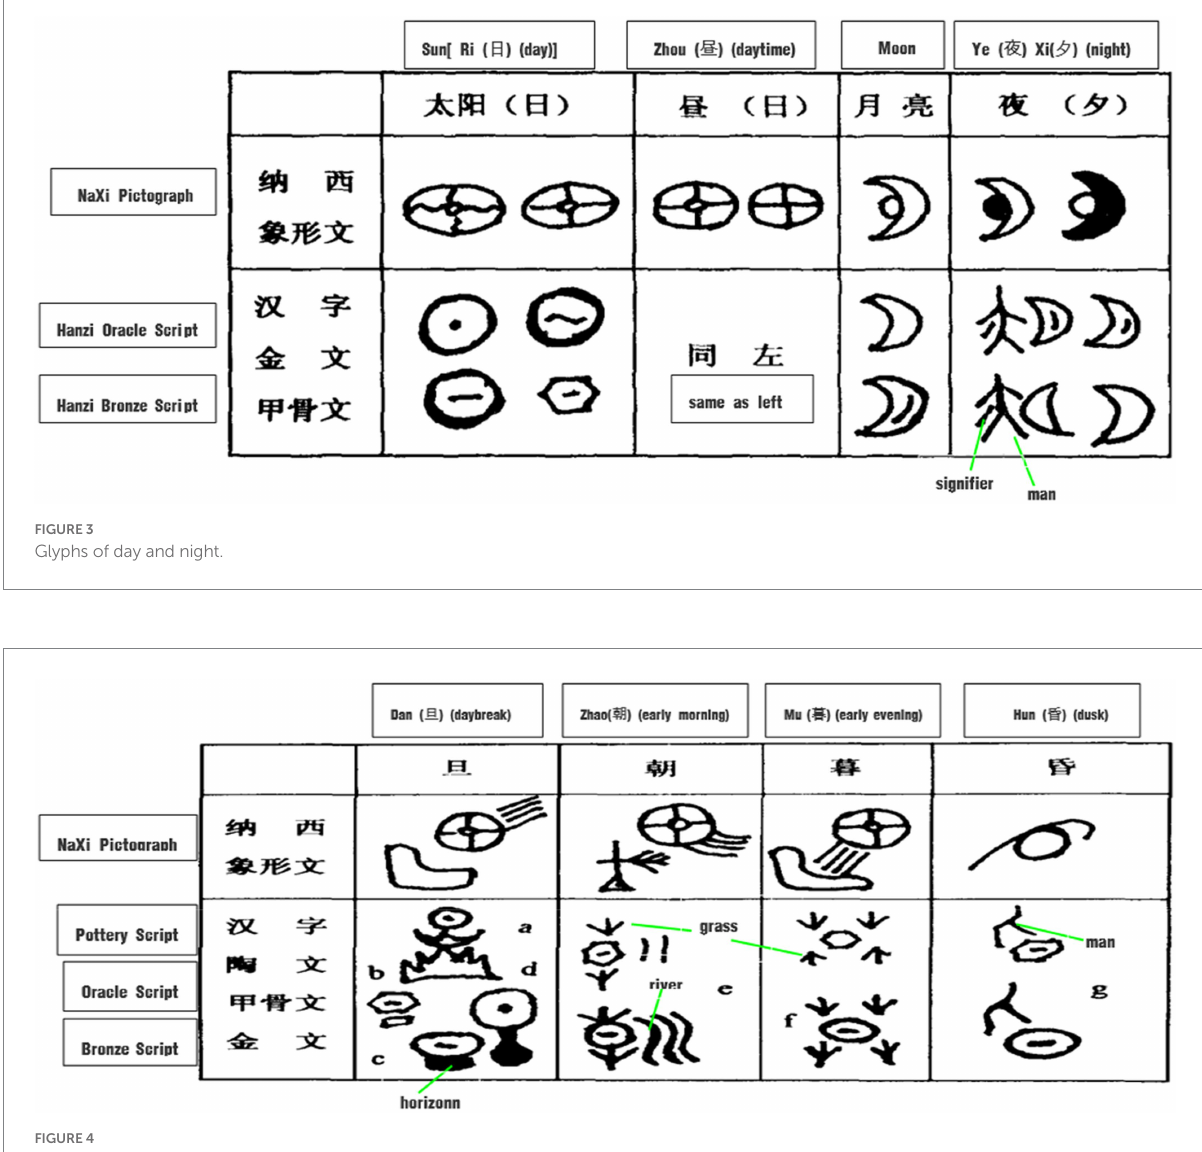
FIGURE 4 Glyphs of daybreak and